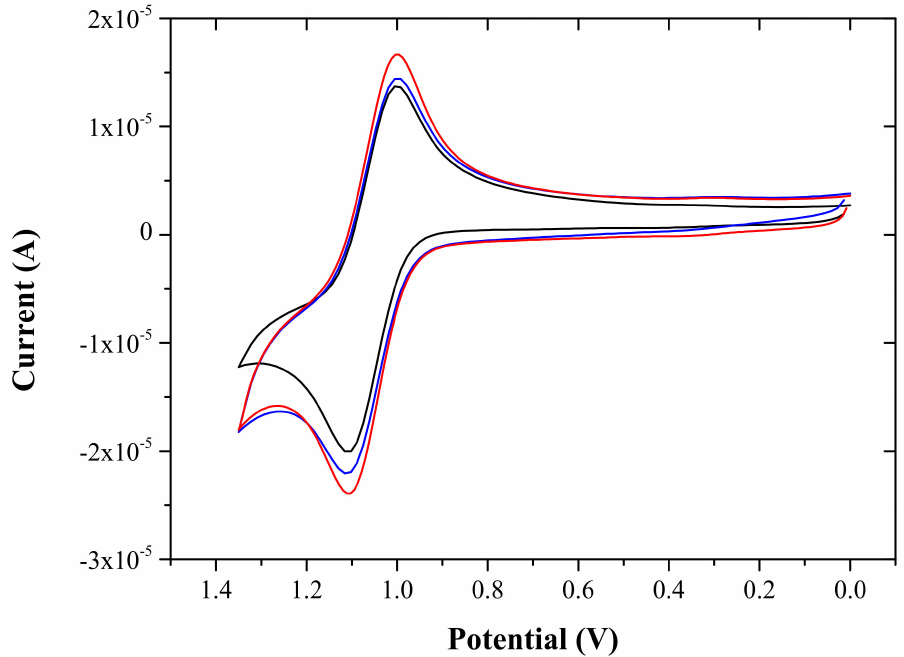
Figure 2. Cyclic voltammograms of 0.5 mM Ru(bpy) 32+ in 0.05 M PBS (pH 7.0) from the titania-Nafion composite-modified (black), graphene-titania-Nafion composite-modified (red), and CNT-titania- Nafion composite-modified (blue) GC electrodes with a scan rate of 100